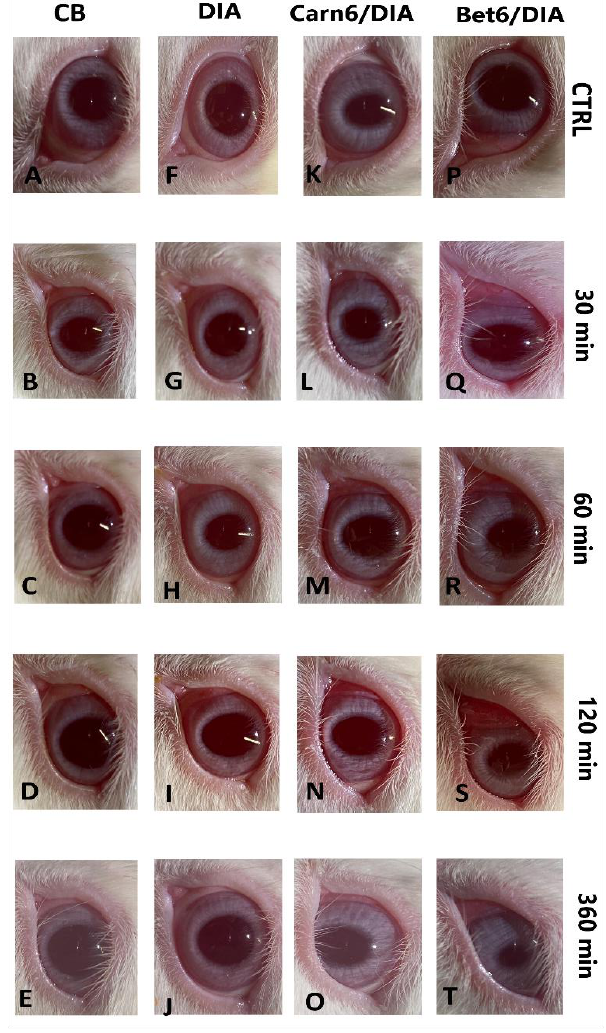
Figure 8. Modified Draize test representation: ( A ) Untreated right eye of rabbit CB used as a reference. ( B – E ) Left eye of rabbit “CB” after instillation of a drop of CB at 30 min, 1 h, 2 h, and 6 h, respectively. ( F ) Untreated right eye of rabbit “DIA” used as a reference. ( G – J ) Left eye of rabbit “DIA” after instillation of one drop of eye drops containing 0.34 M DIA at 30 min, 1 h, 2 h, and 6 h, respectively. ( K ) Untreated right eye of rabbit “Carn6/DIA” used as a reference. ( L – O ) Left eye of rabbit “Carn6/DIA” after instillation of one drop of eye drops containing 0.34 M DIA and 0.27 M Carn6 at 30 min, 1 h, 2 h, and 6 h, respectively. ( P ) Untreated right eye of rabbit “Bet6/DIA” used as a reference. ( Q – T ) Left eye of rabbit “Bet6/DIA” after instillation of a drop of eye drops containing 0.34 M DIA and 0.27 M Bet6 at 30 min, 1 h, 2 h, and 6 h,